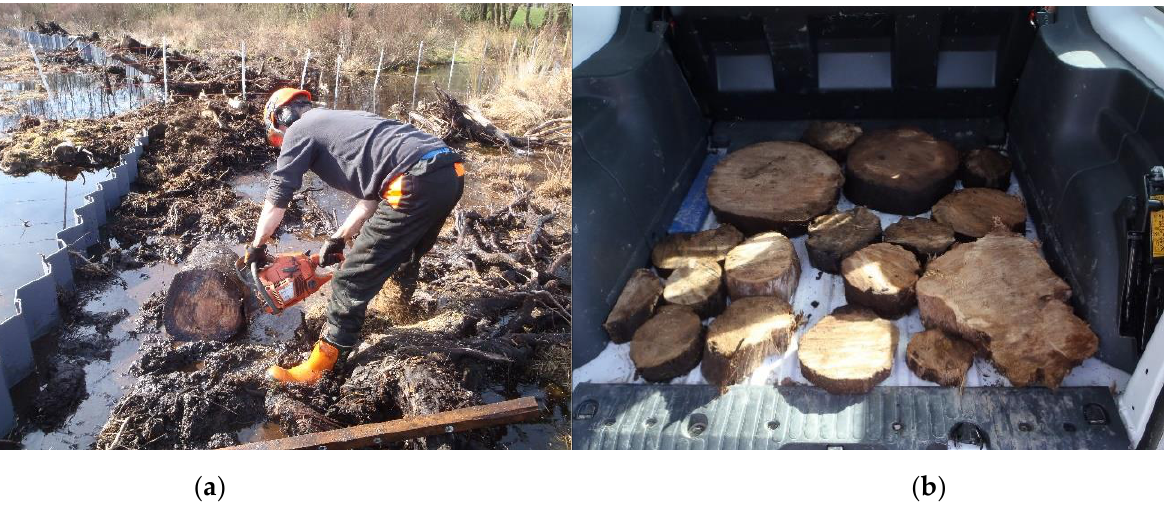
Figure 4. Recovering subfossil bog-pine trees from Wem Moss, Shropshire in March 2015. ( a ) Sam- pling tree discs using a chainsaw from well-preserved stumps close to the tree root crowns. Note cor- rugated plastic barrier inserted into the peat as a hydrological barrier. ( b ) Seventeen pine disc samples prior to transportation to the Dendrochronology laboratory at Manchester Metropolitan